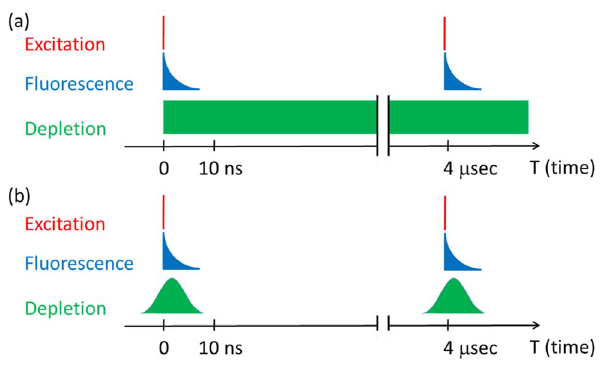
Figure 3. Temporal profile of the excitation pulse, fluores- cence, and depletion beam. (a) In a CW STED configuration, the CW depletion beam at 532 nm illuminates the sample at all time. (b) In the modulated-CW STED configuration, the CW 532 nm laser is modulated by an acousto-optic Bragg cell to generate 10 ns pulses, which significantly reduce the laser exposure to the sample.